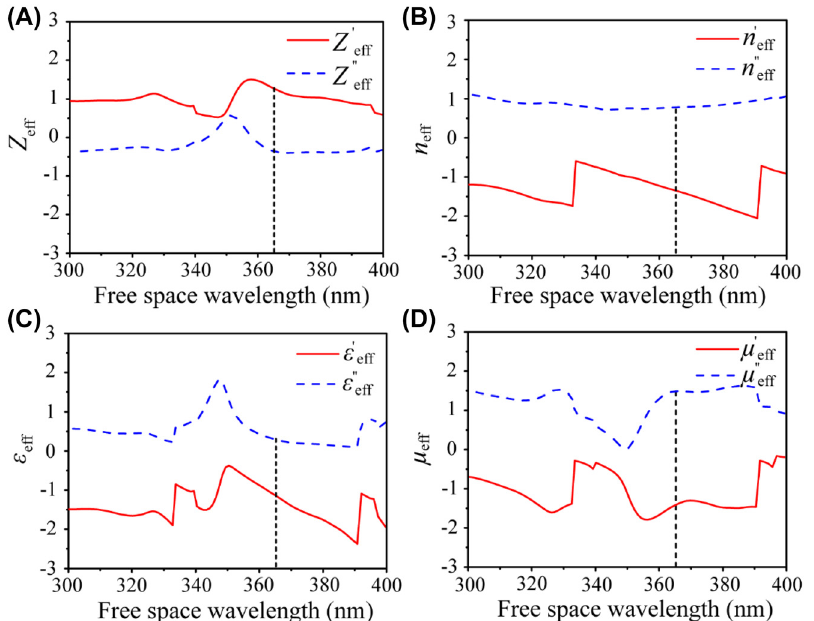
Figure 2: Effective parameters for the designed NIM in the wavelength range